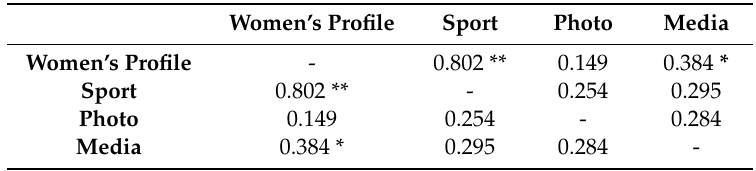
Table 7. Cramer’s Coe ffi cient of the variables “profile of women represented” (athlete vs. non-athlete), “photo”, “sport” and “media.”